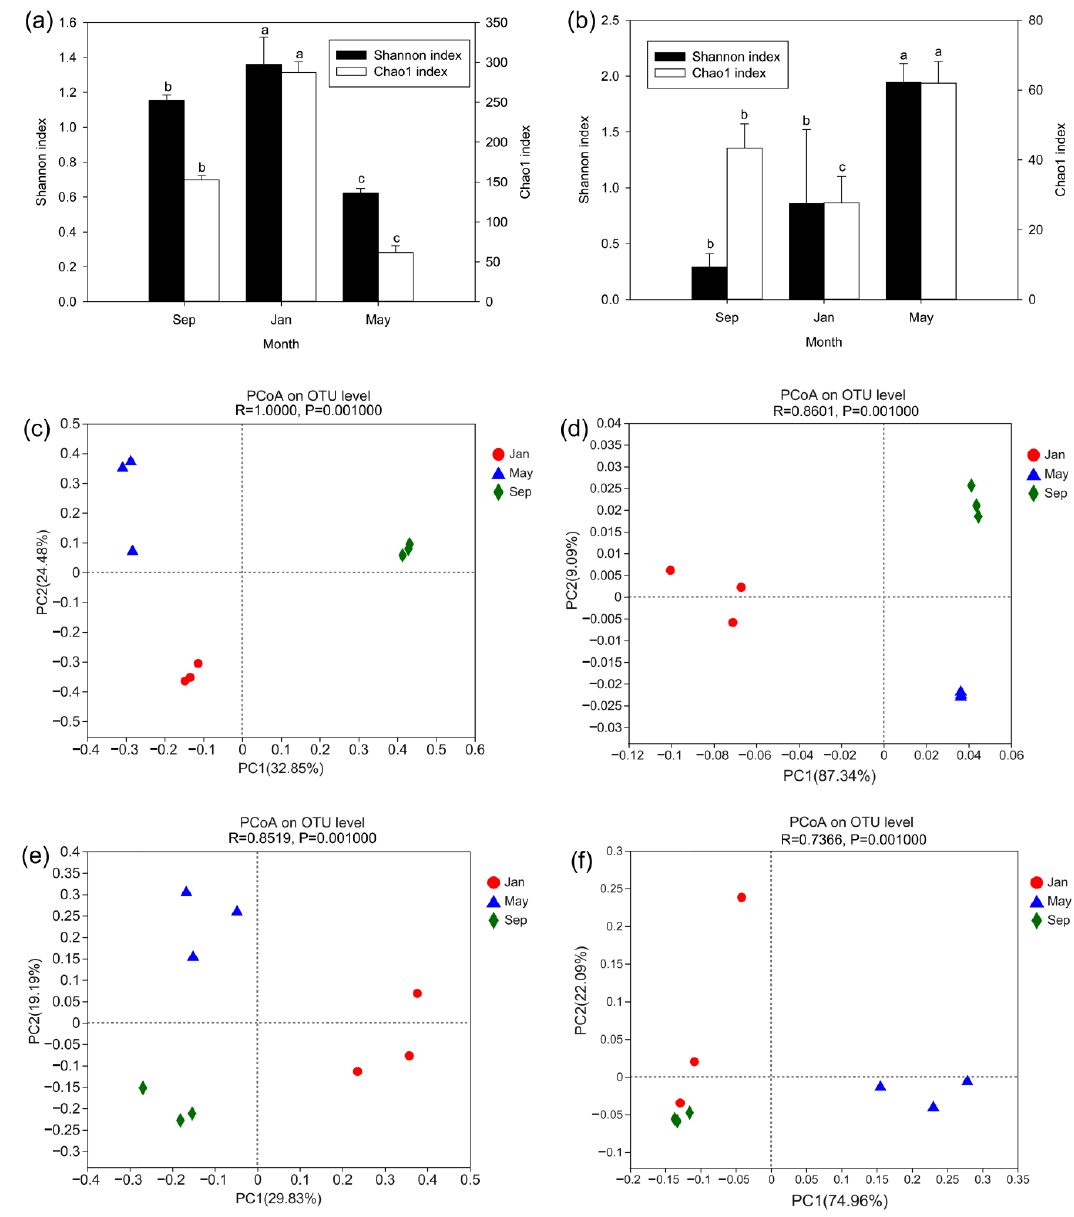
Figure 1. The species diversity and richness of the larval RTB gut microbiome across different seasons. ( a , b ) Species diversity (Shannon index) and richness (Chao1 index) measurements of the bacterial ( a ) and fungal ( b ) communities. Data are shown as the mean ± standard deviation. Different lowercase letters represent significant differences between the groups ( p < 0.05). ( c – f ) PCoA analyses of the bacterial ( c , d ) and fungal ( e , f ) OTUs using unweighted ( c , e ) and weighted ( d , f ) uniFrac dissimilarity matrices.